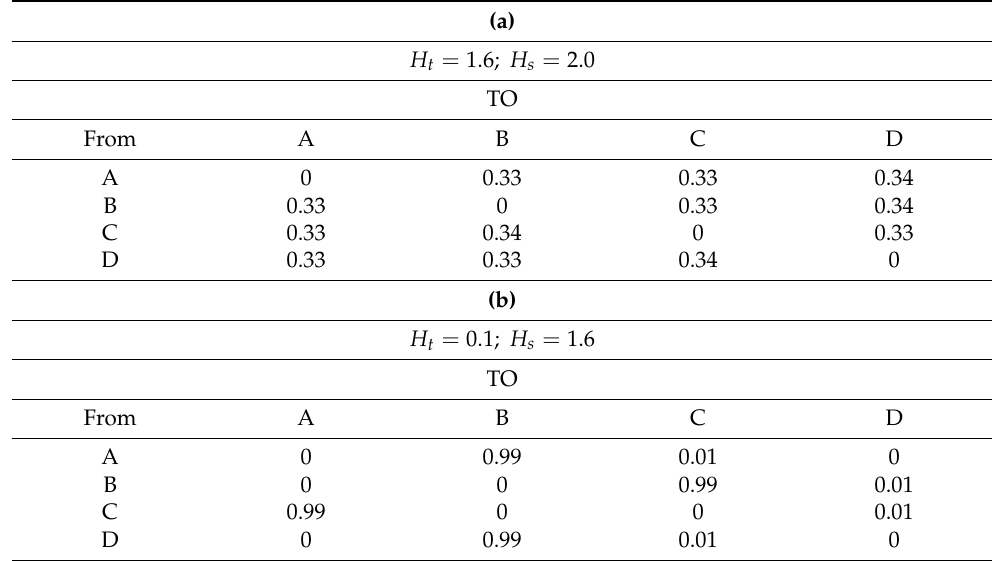
Table 2. Example of two different eye fixation transition probability